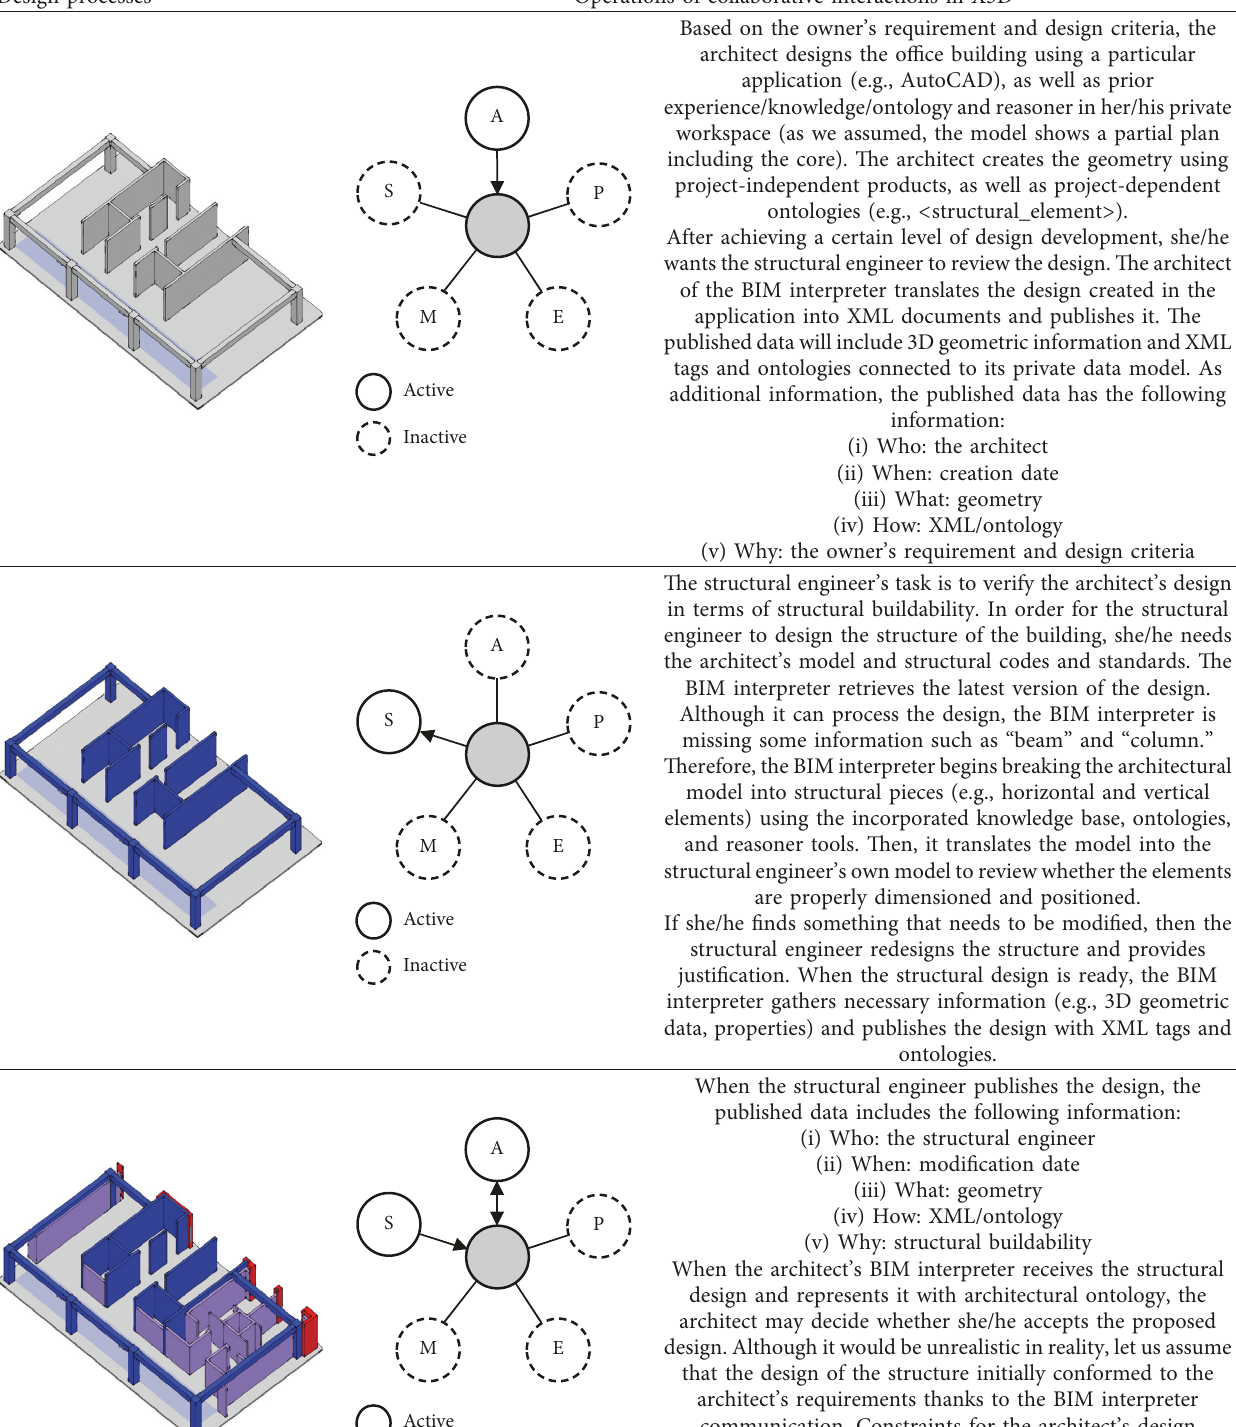
Table 2: The hypothetical case study of the collaborative design process in the BIM EAP Platform. Design